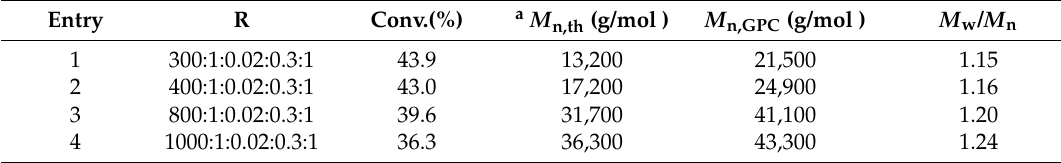
Table 5. Effect of molar ratios of monomer on ICAR ATRP of